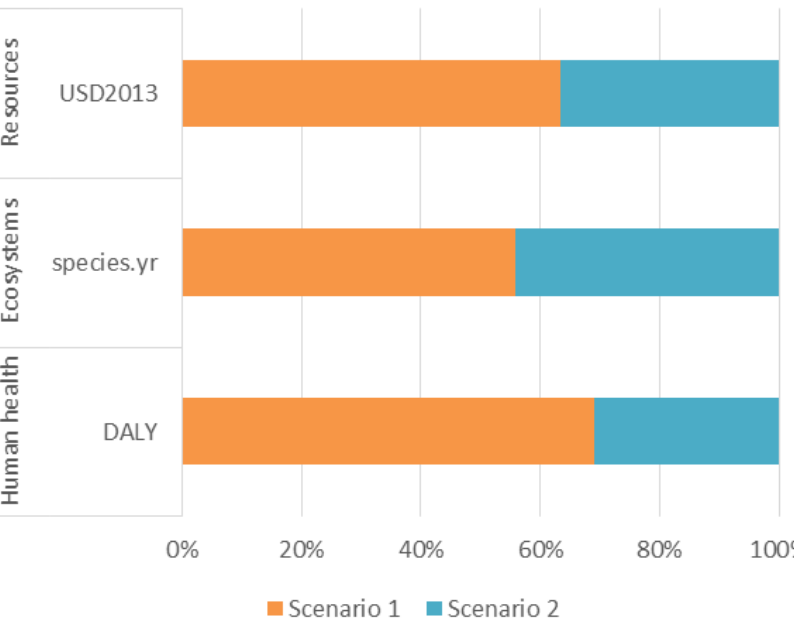
Figure 6. Comparison of the environmental performance of both studied scenarios in terms of their dominance in damage assessment categories available in the ReCiPe 2016 Endpoint (H) method.